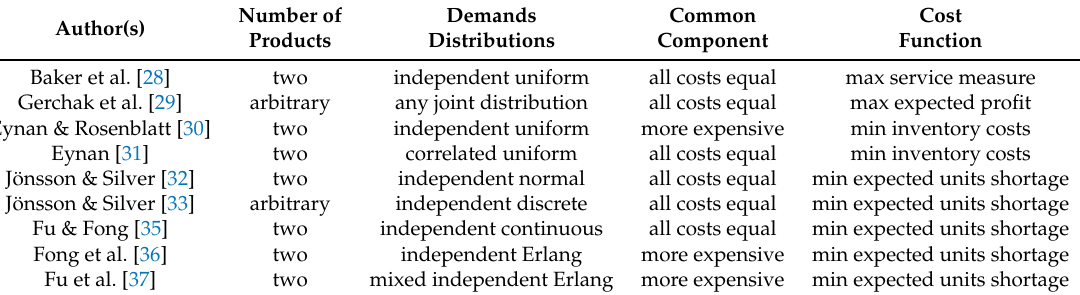
Table 1. Summary of the relevant